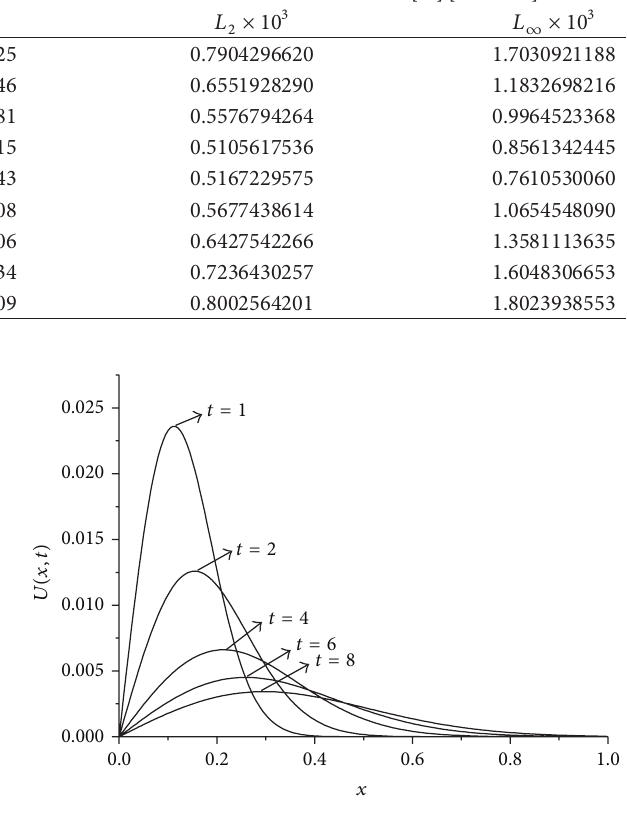
Figure 1: Solution behavior of the equation with ℎ = 0.005 , 𝑡 = 0.01 , and V = 0.01 .